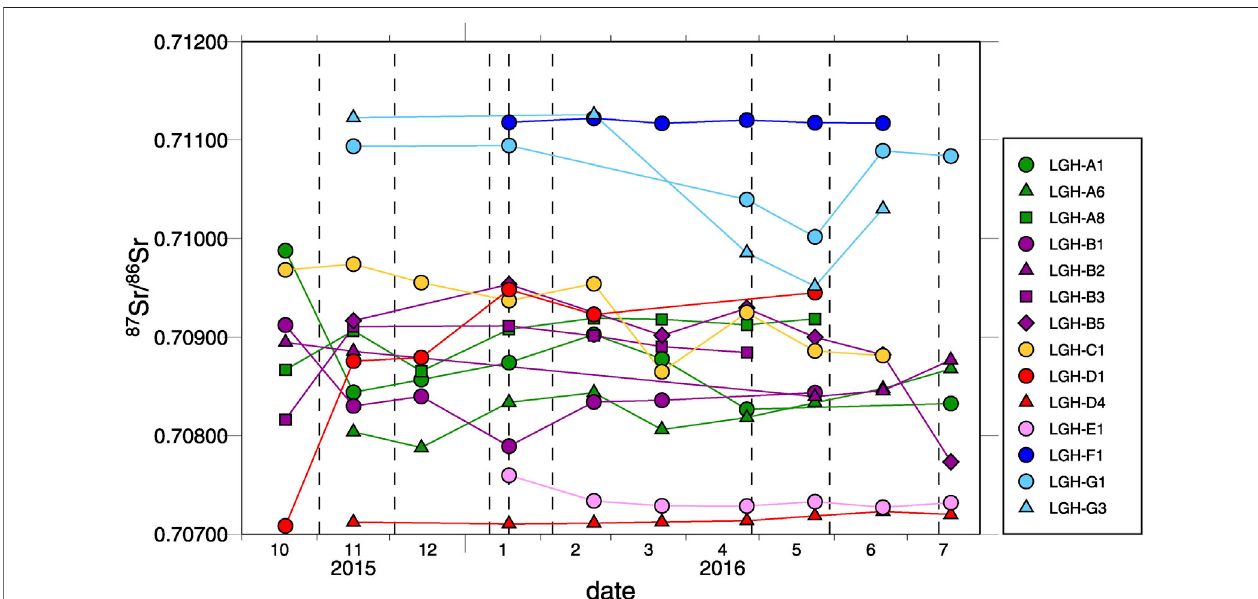
FIGURE8| Temporalvariationplotof 87 Sr/ 86 SrduringthesamplingperiodformudpoolswhichwerecollectedregularlyorhavelonglifetimeinMVLGH.Dashlines indicate the dates of earthquakes, which are documented with peak ground acceleration higher than 8 cm/s 2 at the earthquake station approximately 6 km from MV LGH (data from Central Weather Bureau, 2021). The reproducibility is smaller than the symbol. Two end member representatives, LGH-D4 and LGH-F1, have minor variations while others are